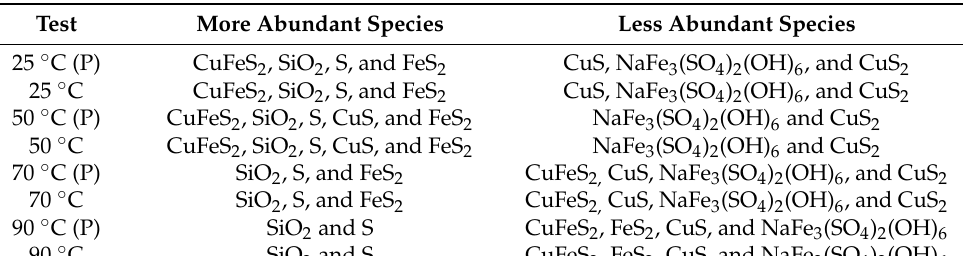
Table 4. Summary of the species identified using X-ray diffraction analysis. Tests with pretreatment are indicated by (P).